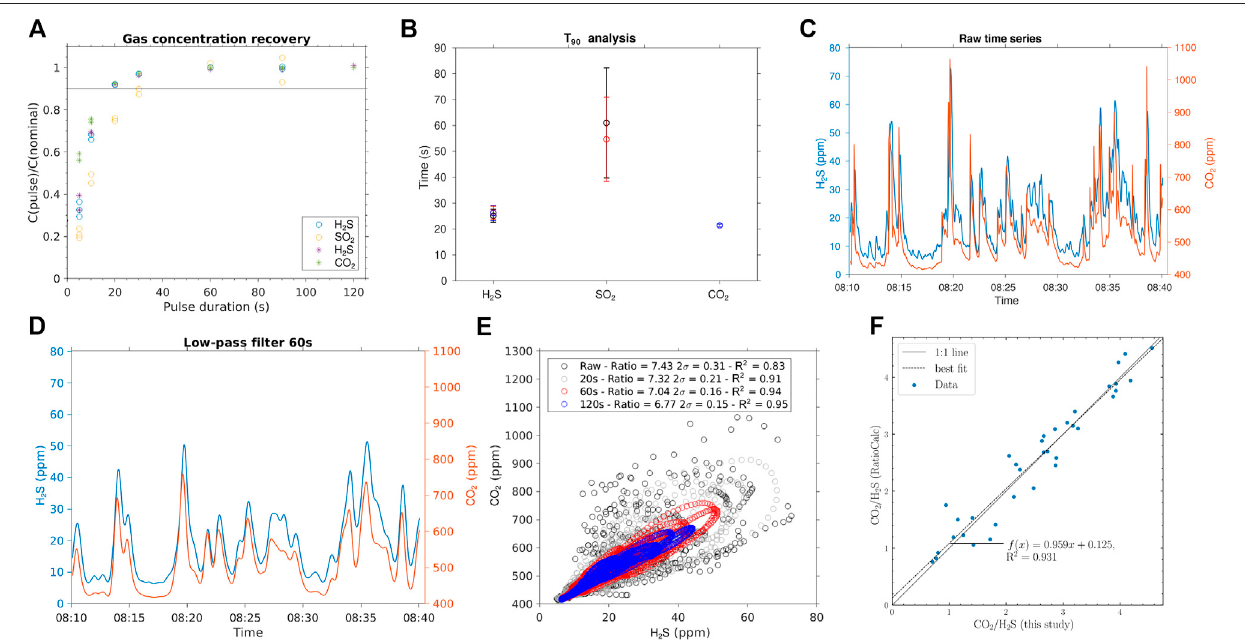
FIGURE 2 | (A,B) t90 behavior of the different sensors (H 2 S, SO 2 , CO 2 ). For H 2 S, we tested two concentrations (100 and 40 ppm) (C) Raw H 2 S and CO 2 time series at CS (D) Same H 2 S and CO 2 time series at CS, but after a 60 s low-pass fi lter (E) The resulting CO 2 /H 2 S ratios with low-pass fi lter with various thresholds [raw (i.e., nolowpass fi lter),20 slow-pass fi lter,60and 120 slow-pass fi lter].The gasratios betweennon- fi ltered and fi ltereddataset arequite similar ( < 6% ofdifference)but weimprove the R 2 (typically 0.8 to 0.9) and 2 σ errors on calculated ratios are decreased by a factor up to ∼ two. (F) Comparison, for the fumaroles of CS, between theCO 2 /H 2 SratiosprocessedinthisstudyandtheCO 2 /H 2 SratioscalculatedwiththeRatioCalcsoftware(Tamburello,2015).Thebest fi tshowsaverygoodagreement between these two data post-processing.